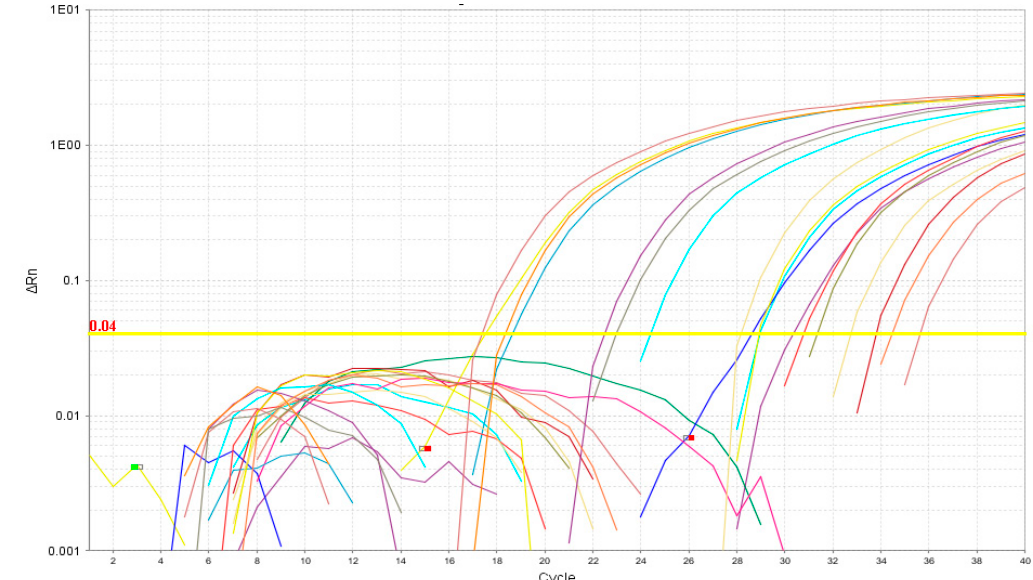
Figure 2. Logarithmic amplification plot.